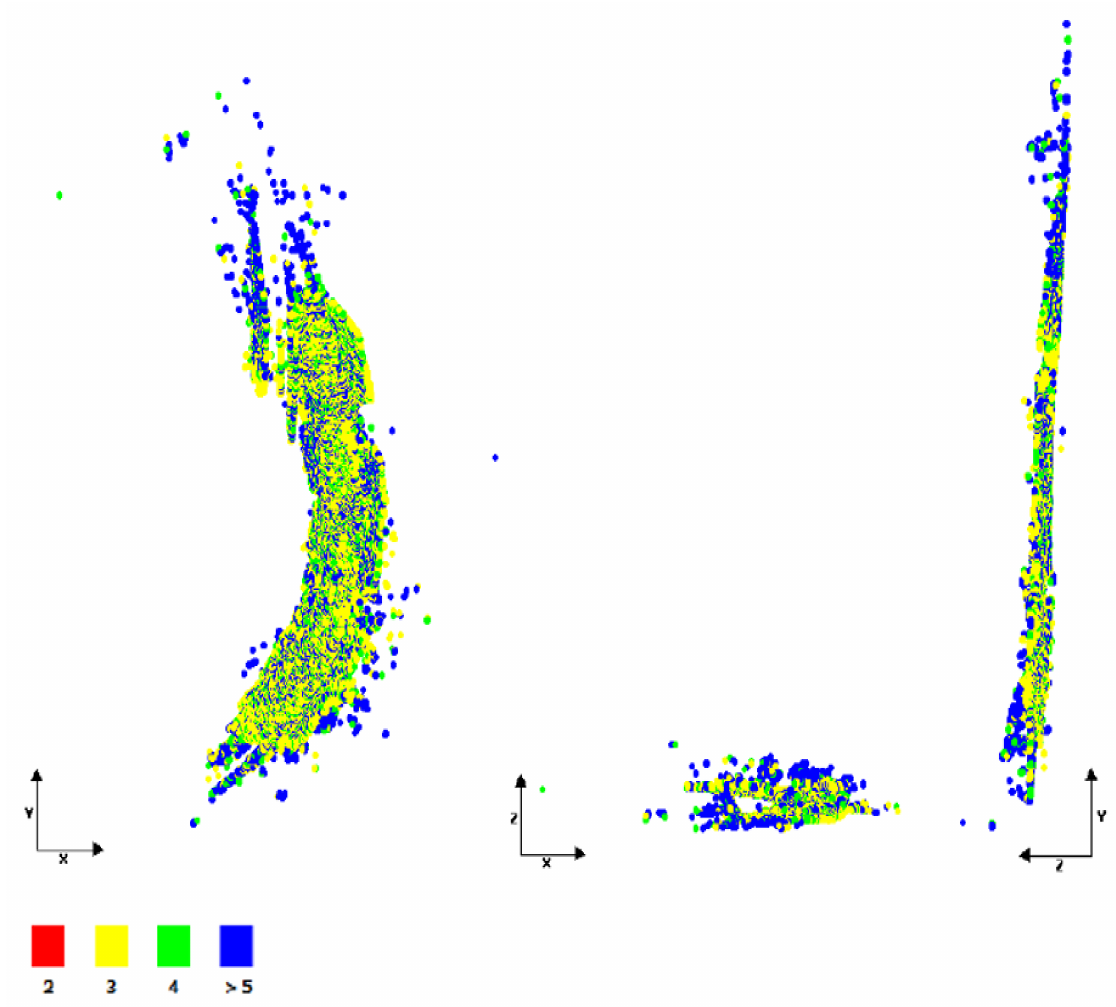
Figure 5. Number of photos that consider the same tie point [#photos /